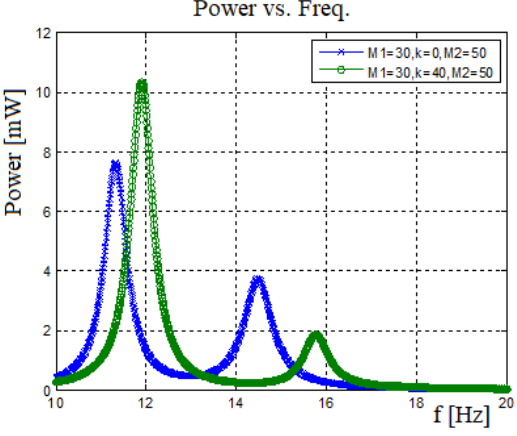
Figure 16. Harvested power: no spring case vs. connected spring case.